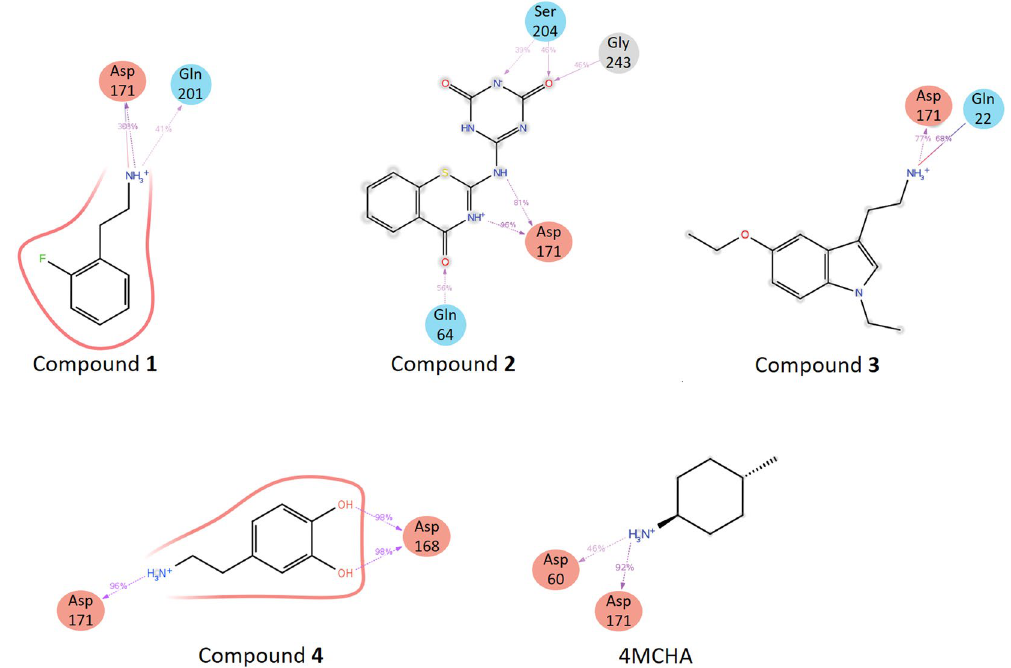
Figure 4. TcSpdSyn-ligand interaction analysis by MD simulation. Schemes of detailed ligand atom interactions with the protein residues are presented. Interactions that occur for more than 30.0% of the simulation time in the selected trajectory (0.00 through 20.00 ns) are